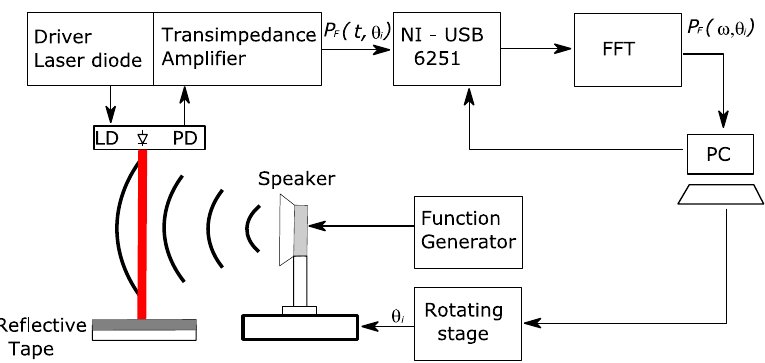
Figure 3. System of measure the sound pressure level of the sound emitted by an acoustic source.